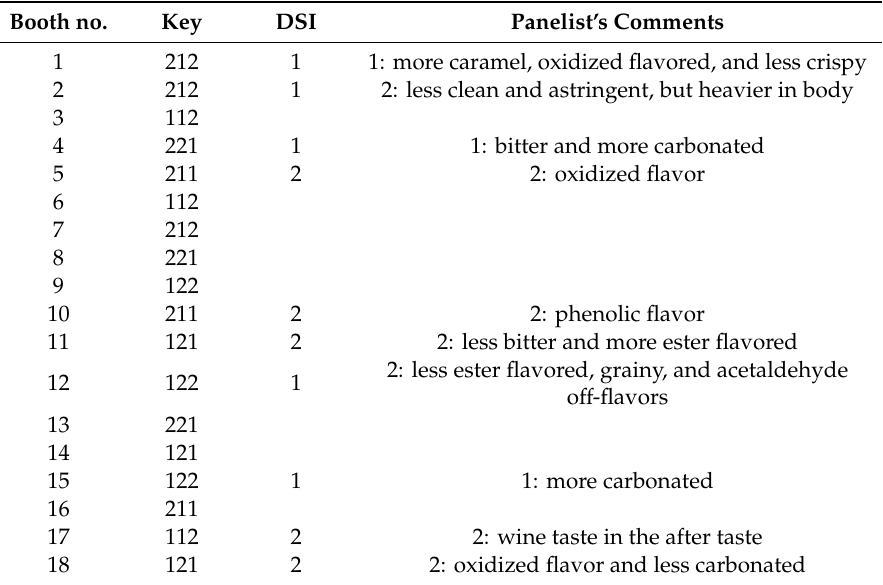
Table 5. Main results of the triangular test: randomized sample presentation order in each booth, di ff erent sample identified (DSI), and comments by each panelist. Booth